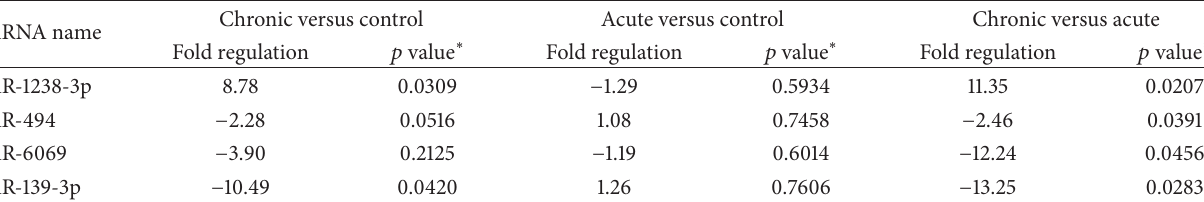
Table 3: List of significantly altered miRNA expressions in chronic brucellosis.